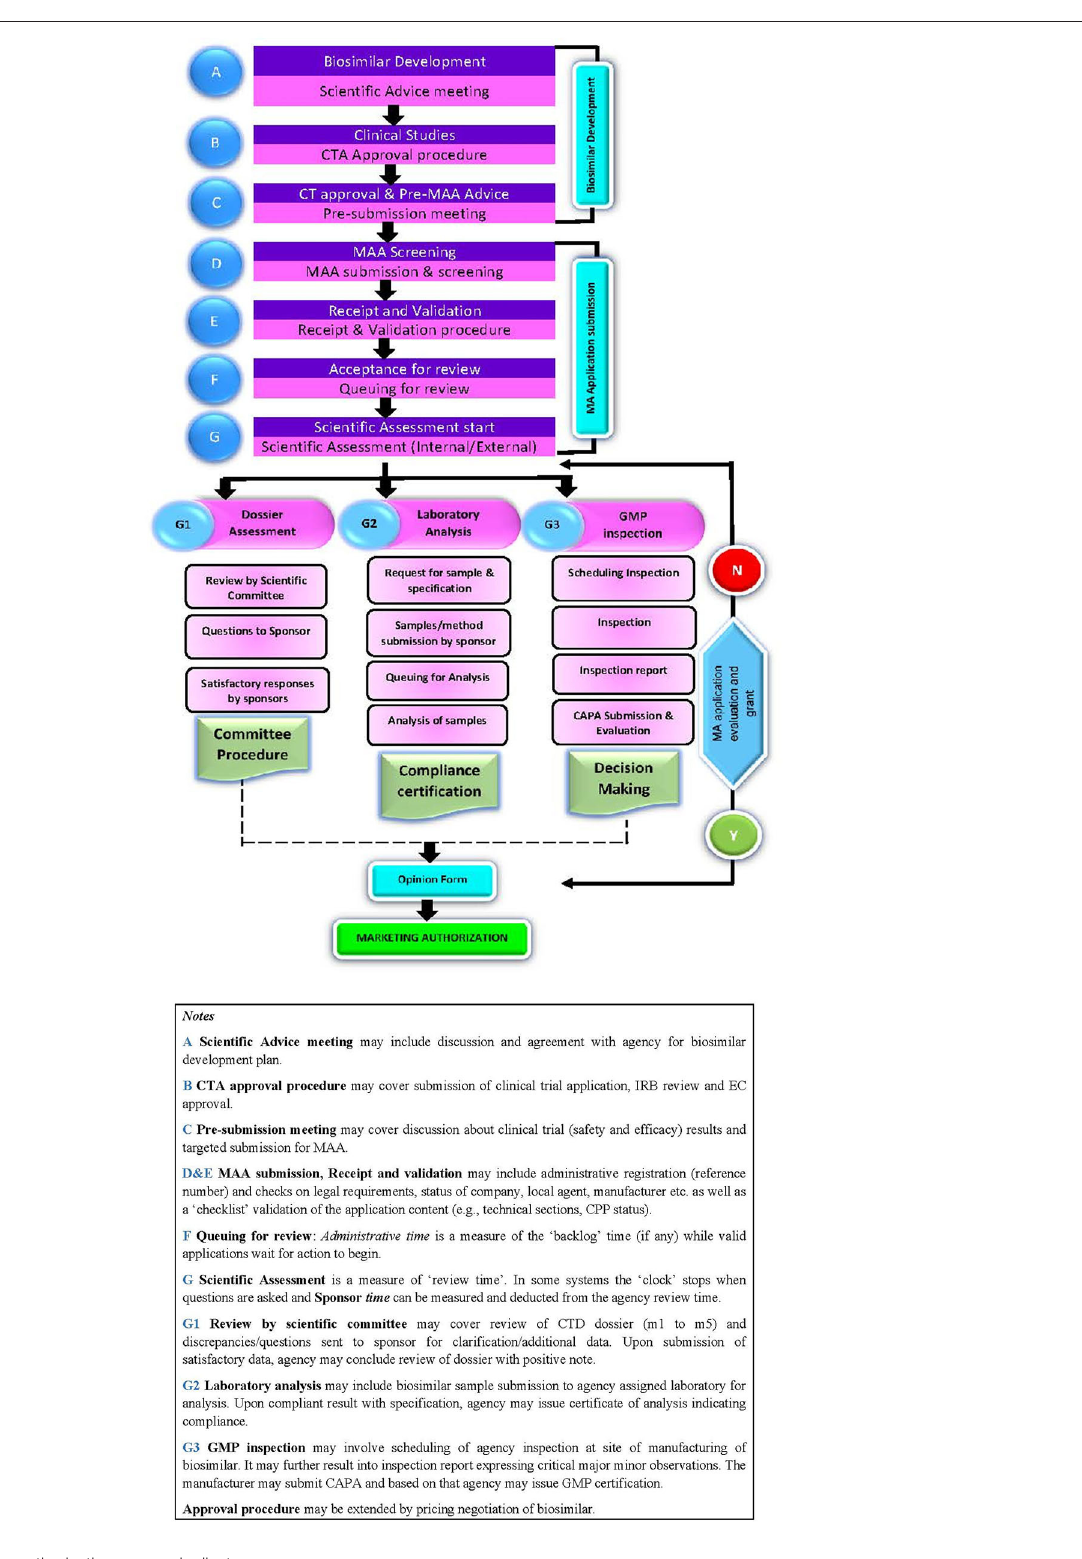
Frontiers in Medicine |